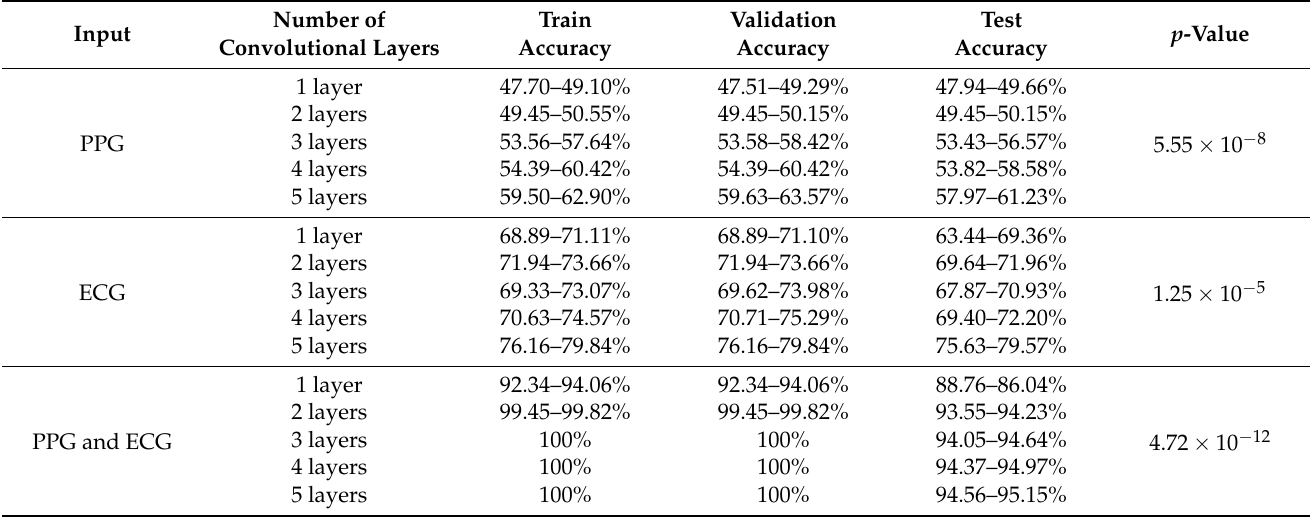
Table 2. Classification accuracy performance with 95% confidence interval and p -value for each input